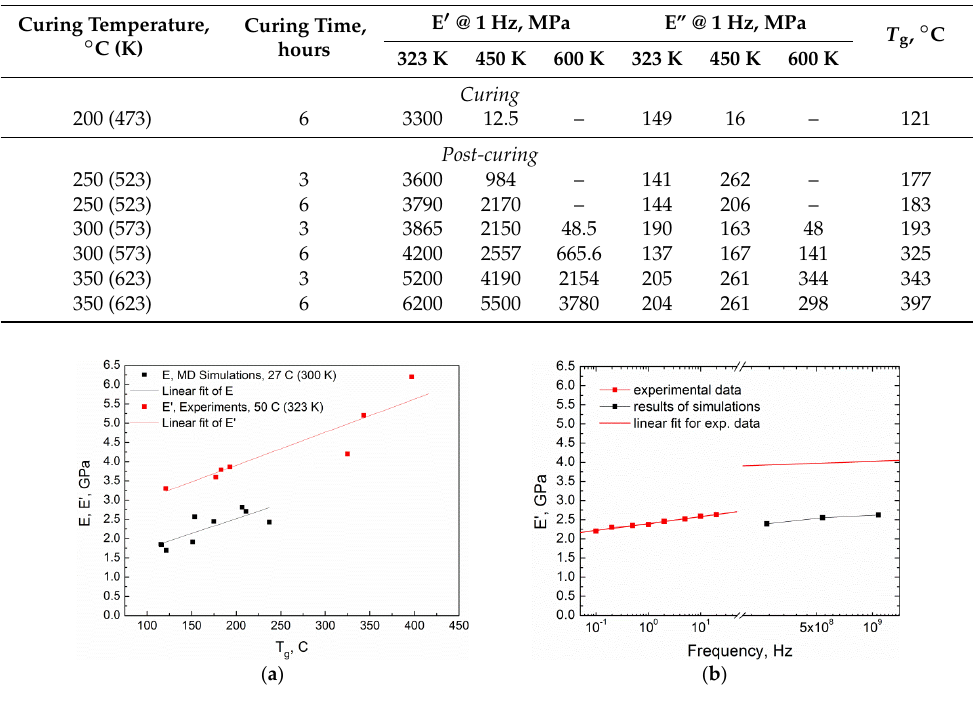
Figure 7. Comparison of the mechanical properties in MD simulations and in experiments: ( a ) The Young’s modulus in MD simulations (at T = 300 K) and the storage modulus in experiments (at T = 323 K) as a function of the glass transition temperature; ( b ) the dynamic moduli, E’, in MD simulations (for the sample of the conversion degree of 0.9) and in experiments (for the sample post ‐ cured at 300 °C for 6 h) as a function of the oscillating frequency. Both simulations and experimental measurements were performed at 450 K.